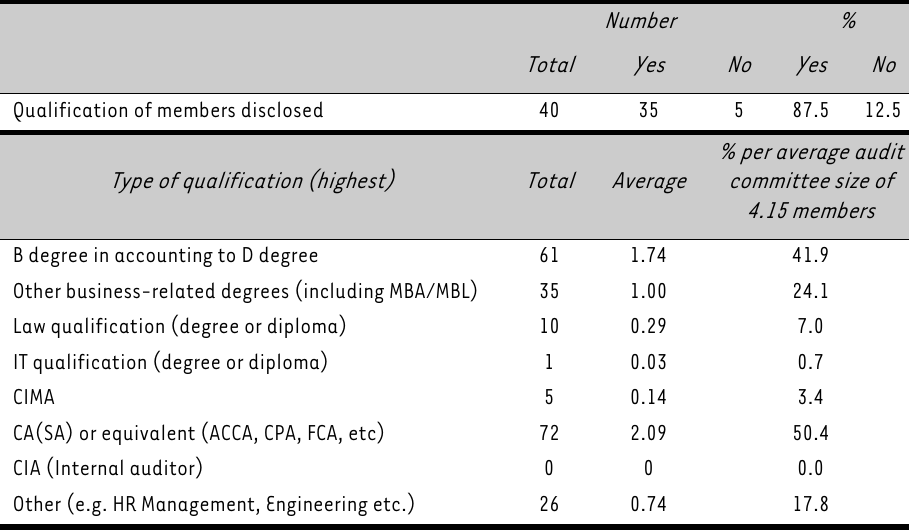
TABLE 1: Qualification of audit committee